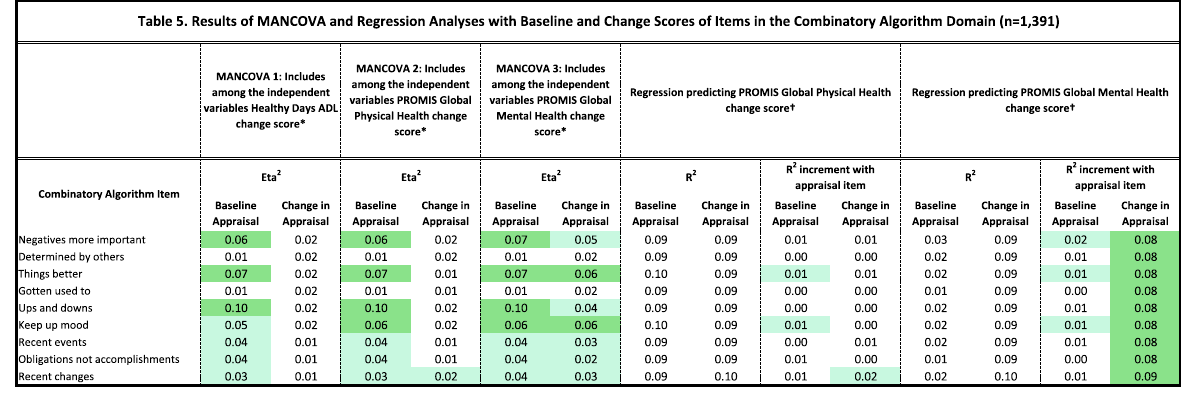
Table 5 Results of MANCOVA and Regression Analyses with Baseline and Change Scores of Items in the Combinatory Algorithm Domain ( n =